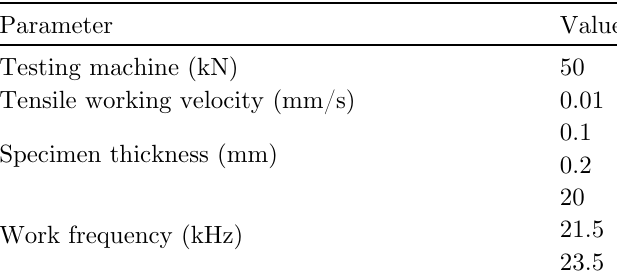
Table 2. Experimental